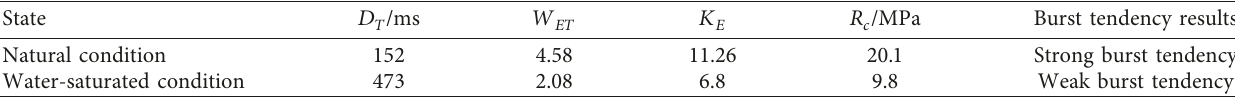
Table 4: The test results of burst tendency of coal seam